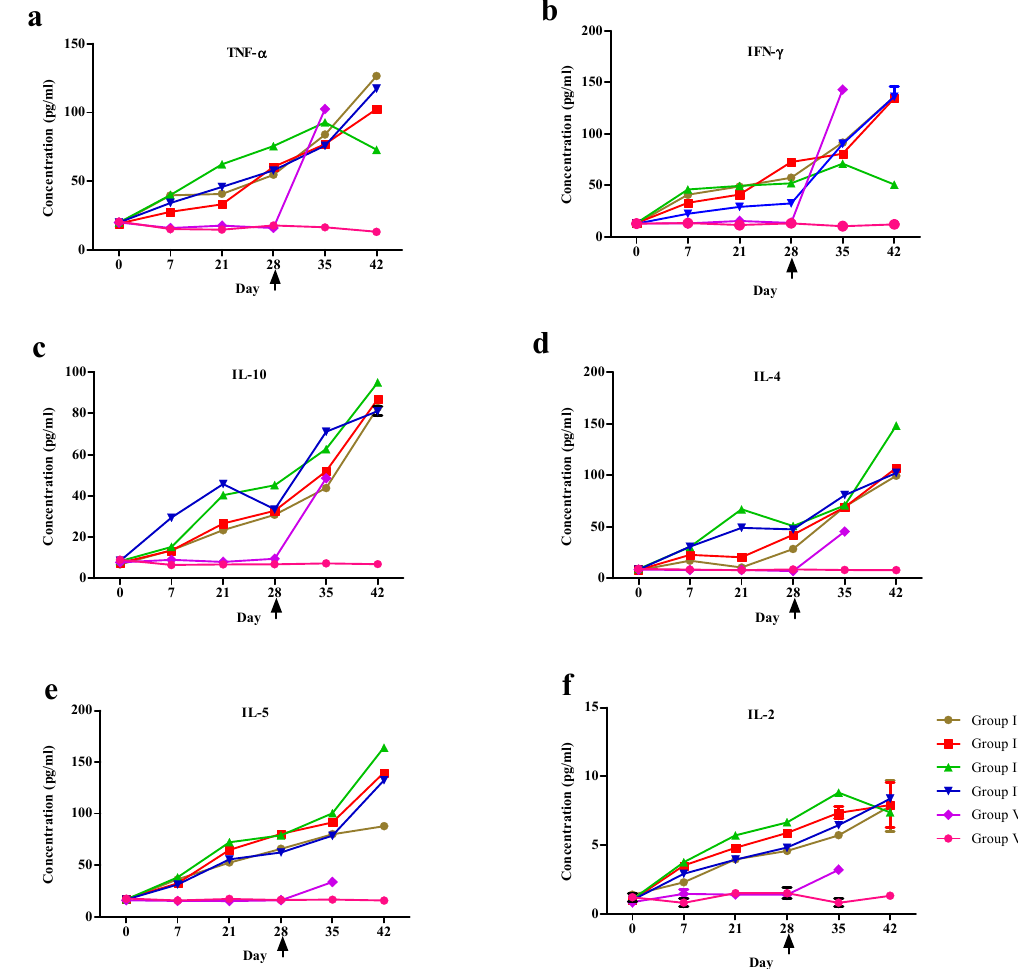
Figure 4. Kinetics of serum TNF- α ( a ), IFN- γ ( b ), IL-10 ( c ), IL-4 ( d ), IL-5 ( e ), and IL-2 ( f ) in rTePFR (Groups I to III), or the adjuvant administered control mice (Group V) on days 0, 7, and 21. The mice were challenged with T. evansi blood-stream forms on day 28 (arrow). The response was compared with that of the native T. evansi whole cell lysate antigen immunized group (Group IV). Data presented as Mean ± SEM from the surviving mice in each group. Note, day 42 (equivalent to 14 days post-challenge) is the last data point presented, after which mortality begun to undermine representative group sizes.